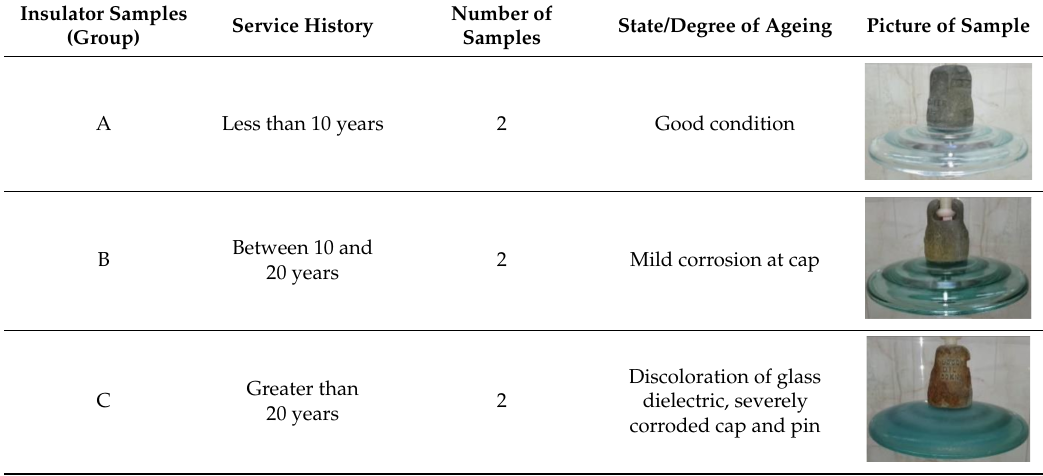
Table 2. Insulators sampled (description).